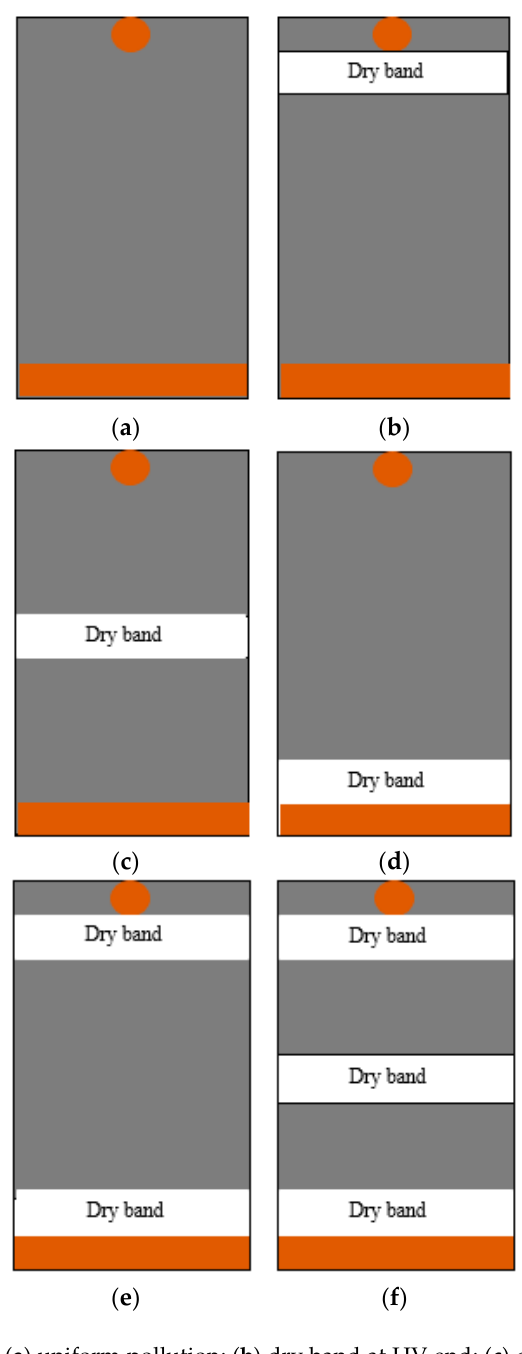
Figure 3. Test samples: ( a ) uniform pollution; ( b ) dry band at HV end; ( c ) dry band at middle part; ( d ) dry band at ground end; ( e ) two dry bands; and ( f ) three dry bands.